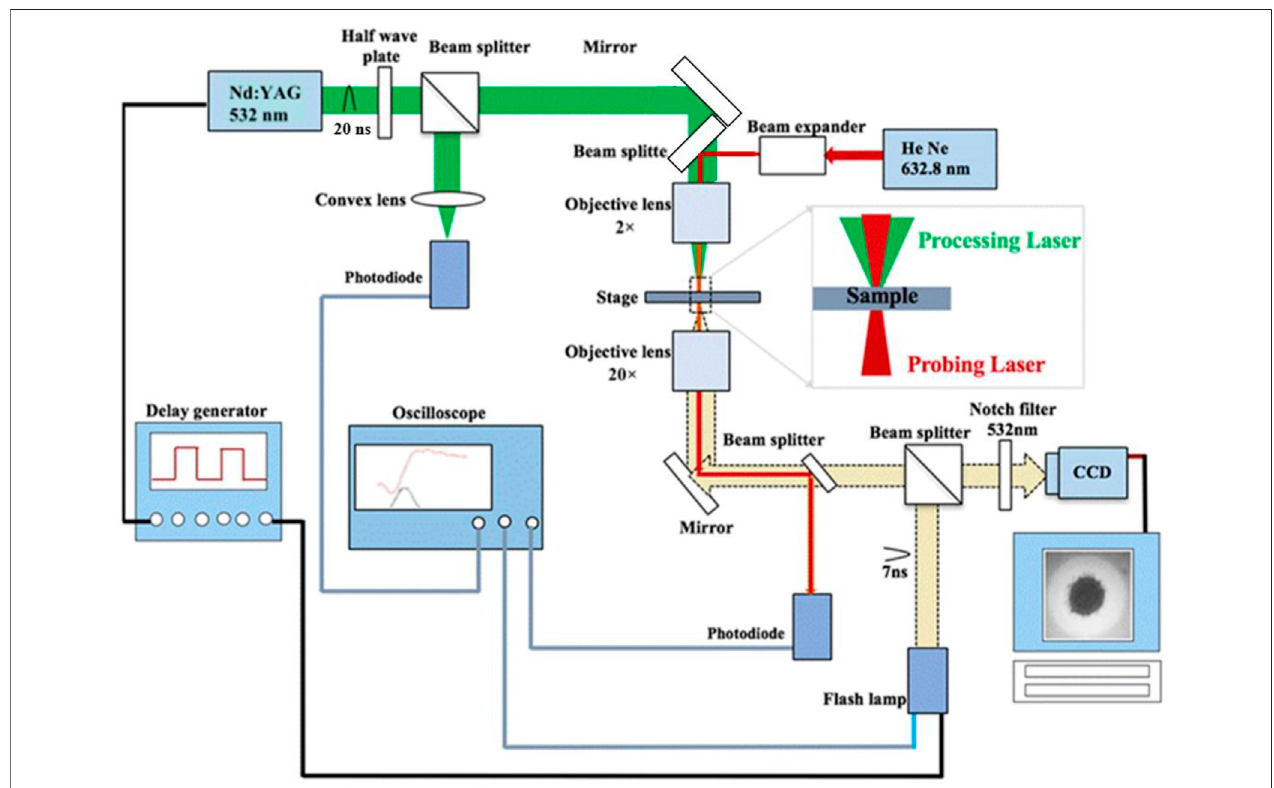
FIGURE 1 | The schematic of the experimental setup including the laser system, the time-resolved imaging, and the pump-probing transmittance measurement setups.